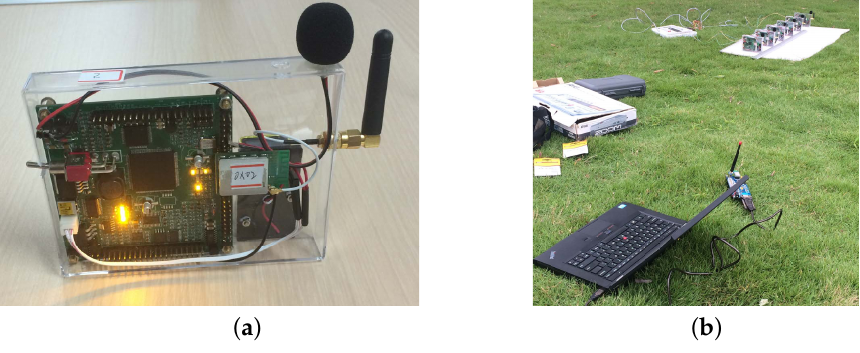
Figure 10. Wireless sensor array network. ( a ) Sensor node; ( b ) fusion center and array.